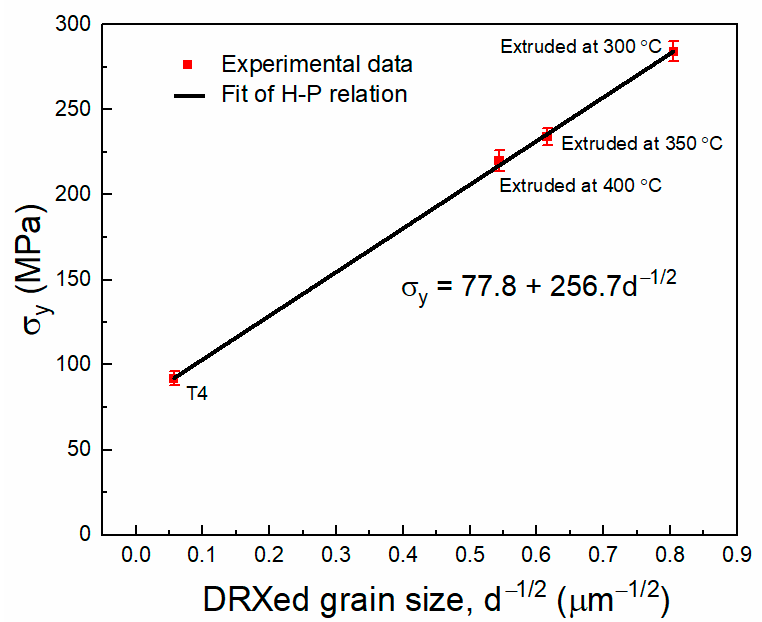
Figure 14. Hall–Petch plots of the σ y against d − 1/2 for the extruded ZX10 alloy. Secondly, it has been reported that the strong basal texture in the extruded Mg alloys